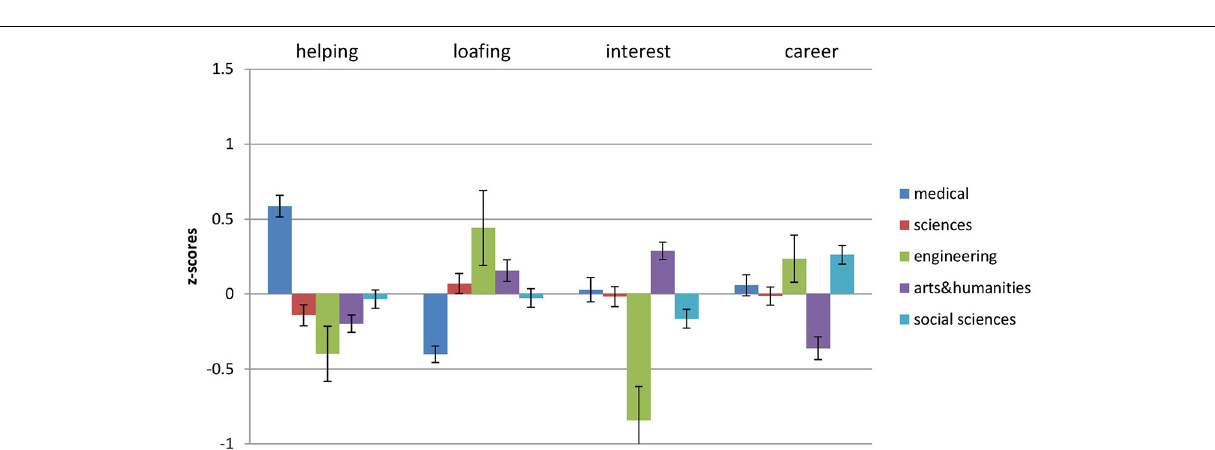
FIGURE 6 | Z-scores for Helping, Loafing, Interest and Career across all degree types in the potential students sample. Error bars represent the standard error of the